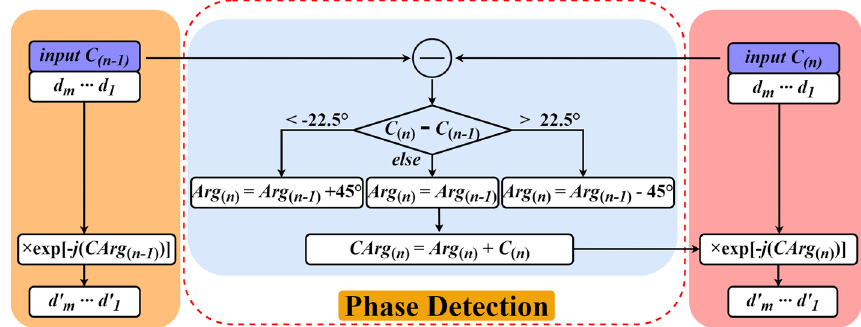
Fig. 3 Phase detection of 32-Point 6PolSK-QPSK with the eighth